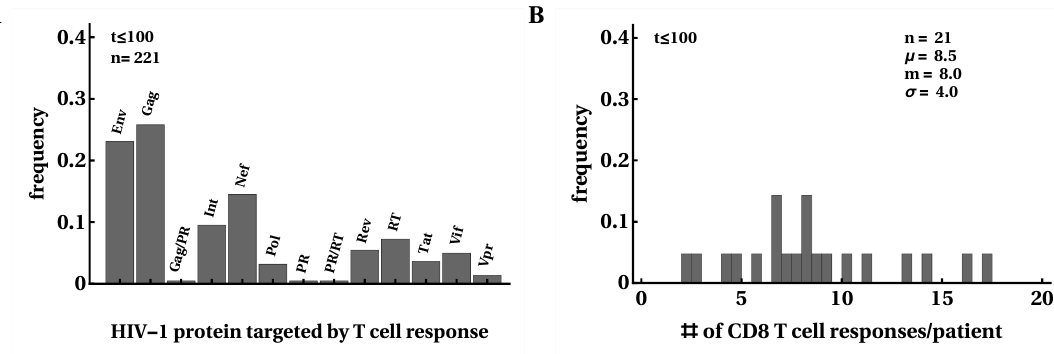
Figure 2. Most HIV proteins were recognized by CD8 + T-cell responses. We calculated the frequency at which HIV proteins were recognized by CD8 + T cells; overall, 50% of responses were directed against Env or Gag ( A ). m = 8 CD8 + T cell responses were detected in this cohort of 22 patients at any given time point after infection ( B ). In B (and other figures in the paper), µ denotes the average, m is the median, and σ is the standard deviation. The distributions are shown for the first 100 days after symptom onset but, overall, distributions changed little over the course of 400 days of infection. Patient SUMA0874 was excluded from the analysis in B due to a lack of measurements of all T-cell responses at all time